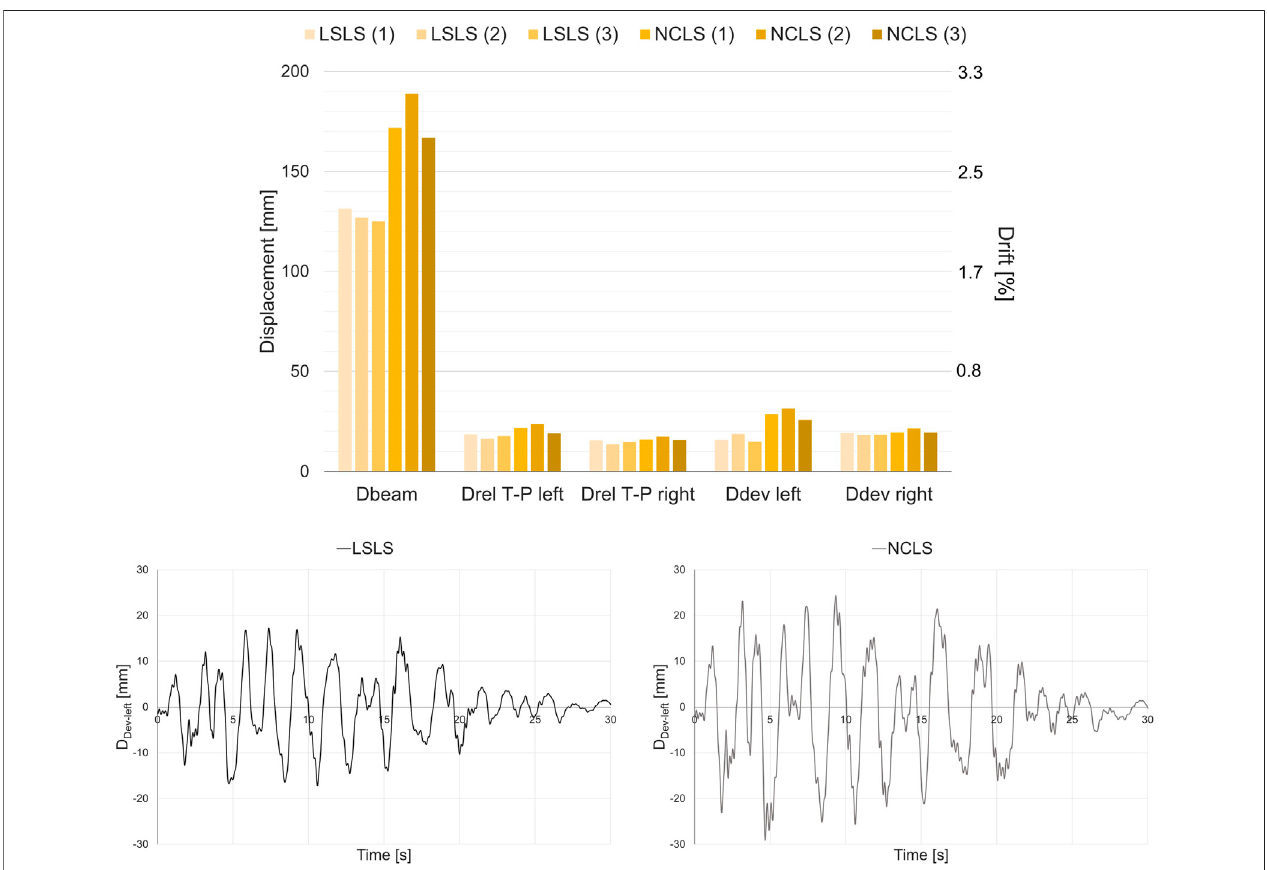
FIGURE 13 | Non-linear response history analyses